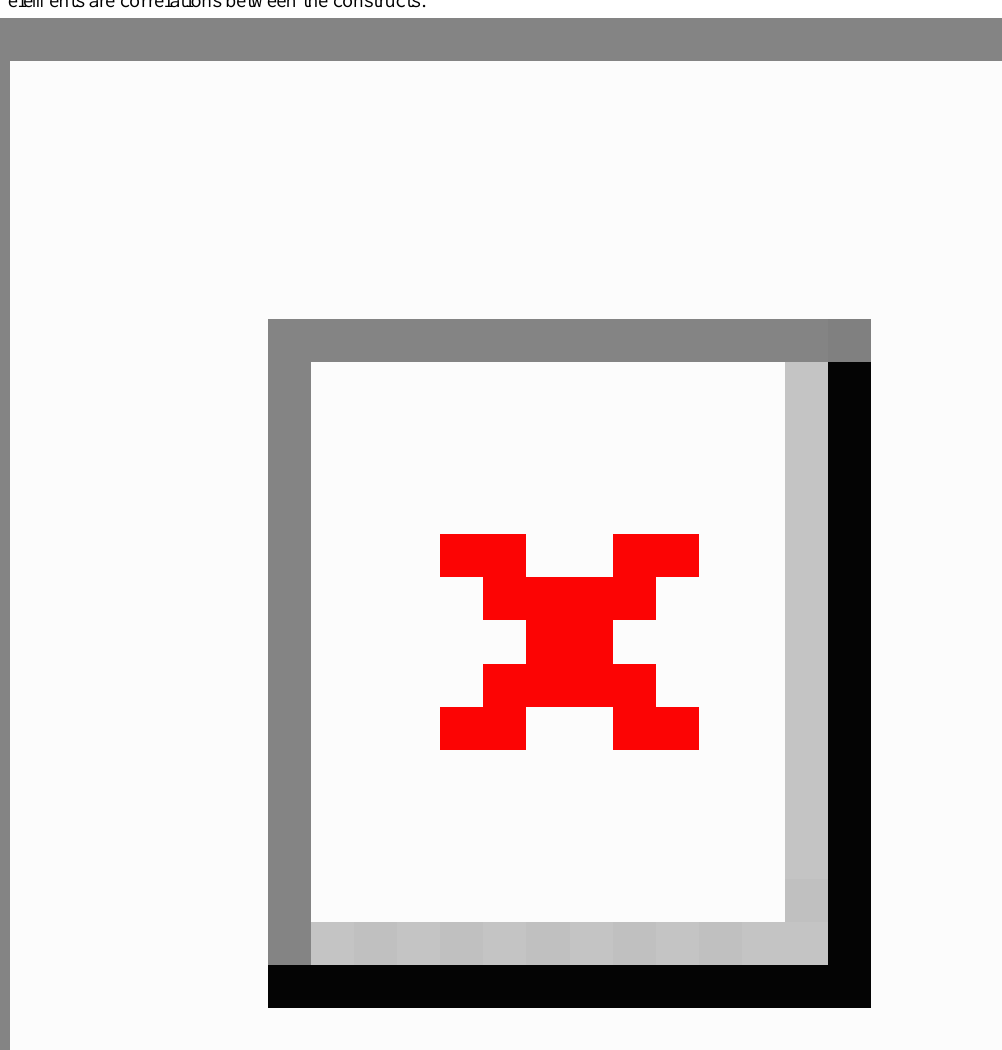
Figure 3. A heat map showing correlations and discriminant validity. The diagonal elements denote the square root of average variance extracted, and all other elements are correlations between the